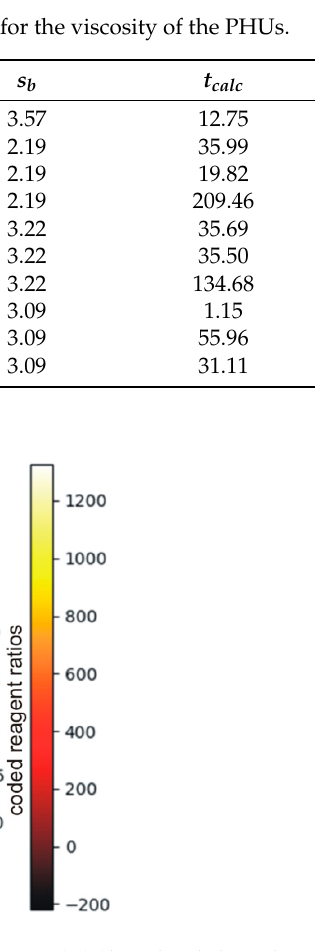
Figure 11. The plot of the function described by Equation (19) (the values below 0 have no physical meaning). Each point was described by 4 variables. The independent variables were ascribed to X, Y and Z axes, while viscosity was illustrated by the color. It is clear that the aromatic DCBPA (coded variable +1) yielded the PHUs of viscosities nearly two orders of magnitude higher when compared to other experiment runs. Additionally, coded variables at levels 0 and − 1 result in viscosities differencing by decimals of order of magnitude. In such cases, a quadratic polynomial has an insufficiently flexible function to accurately model the existing relations. Table 10. A comparison of actual and modeled properties of an optimized PHU.